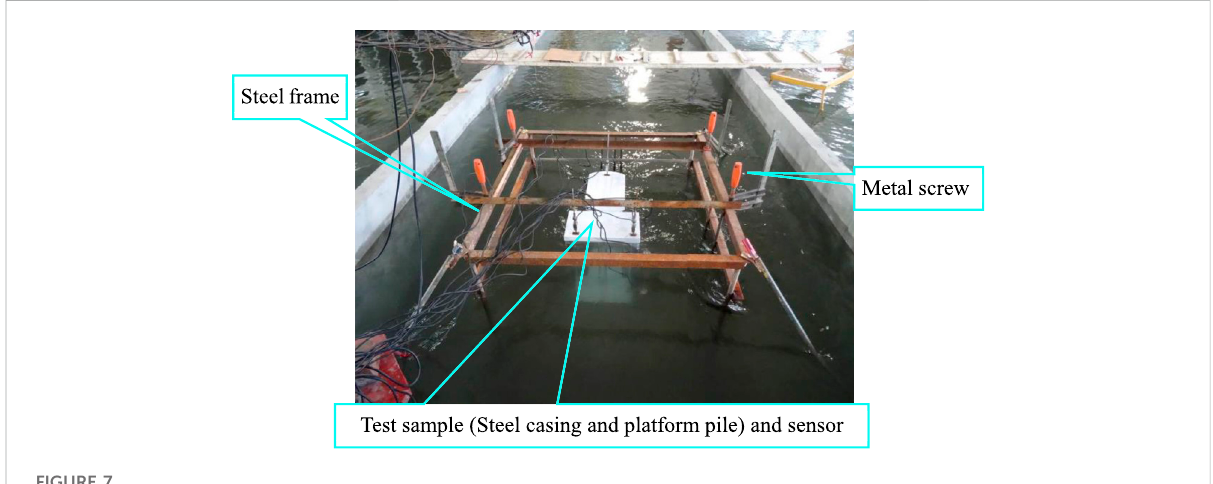
FIGURE 7 Test model and sensor installation.